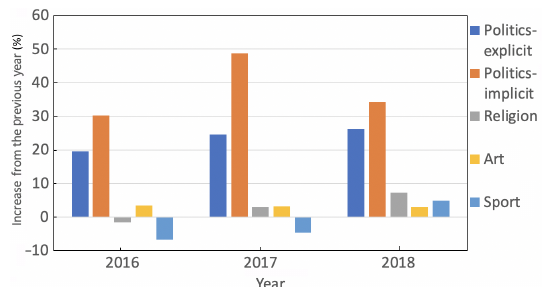
Fig. 2 Growth rate of bio keywords categories, by year— cross-sectional sample.